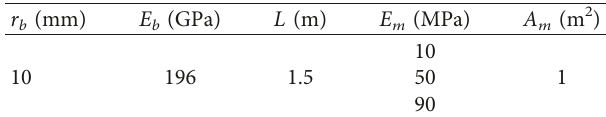
Table 5: Mechanical properties of the bolt and the confining medium.